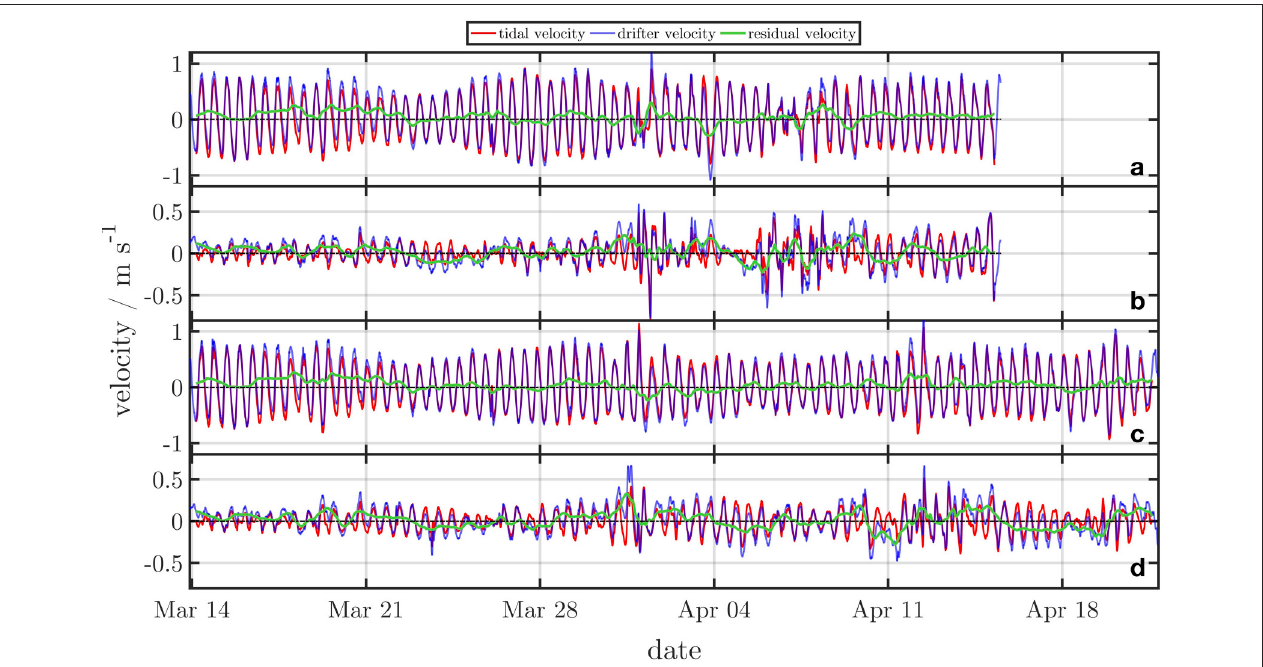
FIGURE 8 | Time series of drifter-derived velocities (blue line) of D1 of the zonal component (A) and the meridional component (B) and D2 (C,D) . The estimated tidal velocities are indicated by the red line and the residual velocities are highlighted as a green line.